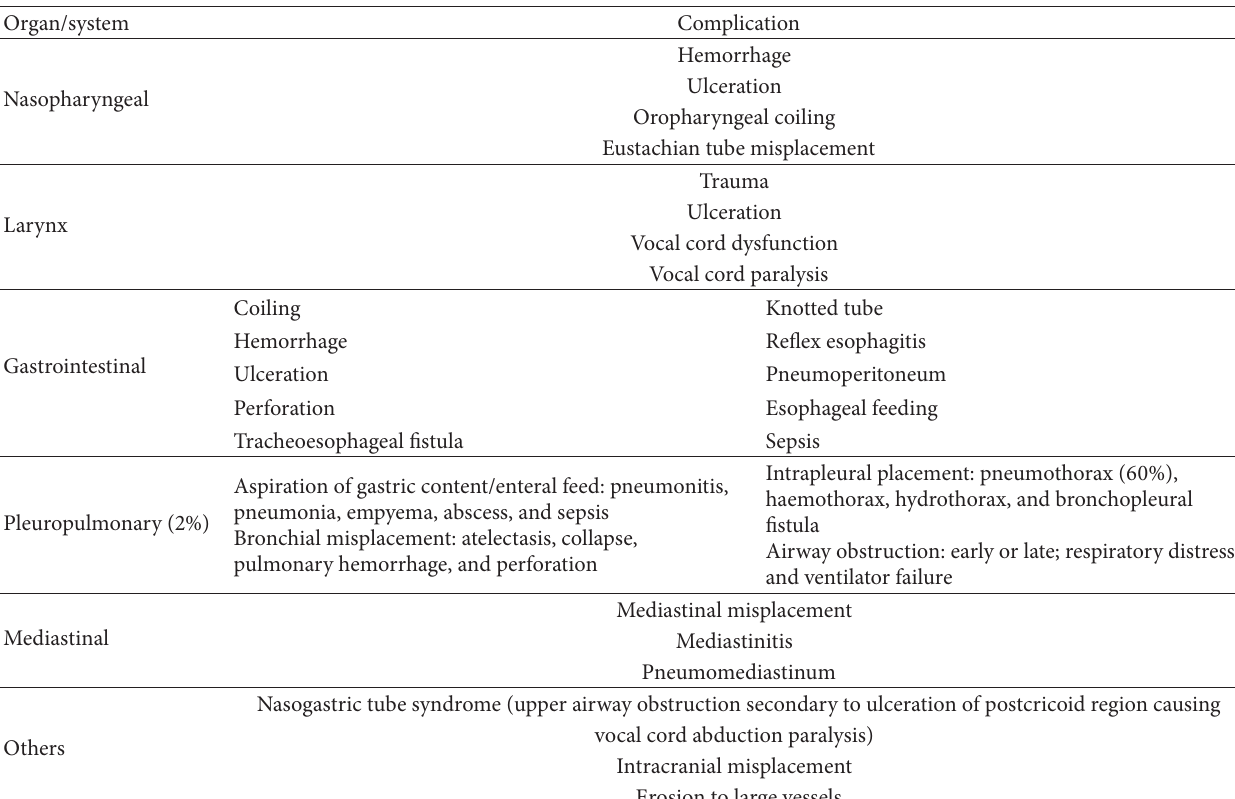
Table 1: Complications of nasogastric tubes insertion.